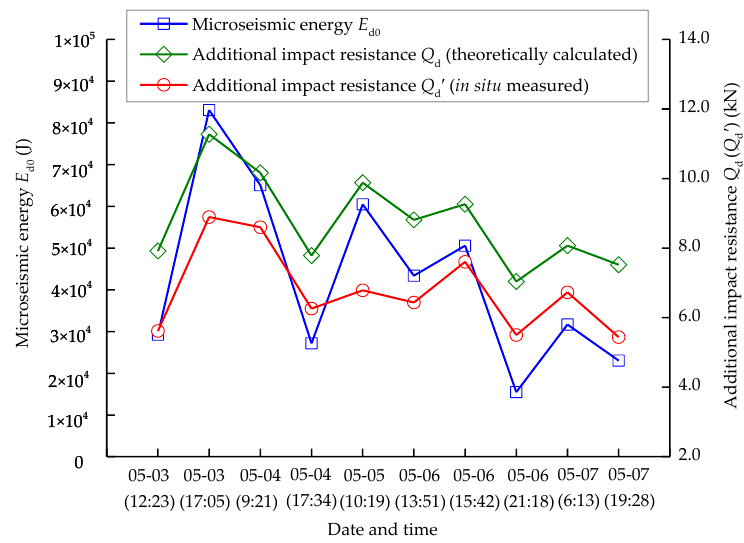
Figure 19. Distributions of microseismic energies (>10 4 J) and additional impact resistances in the prevention area (3−7 May 2014).